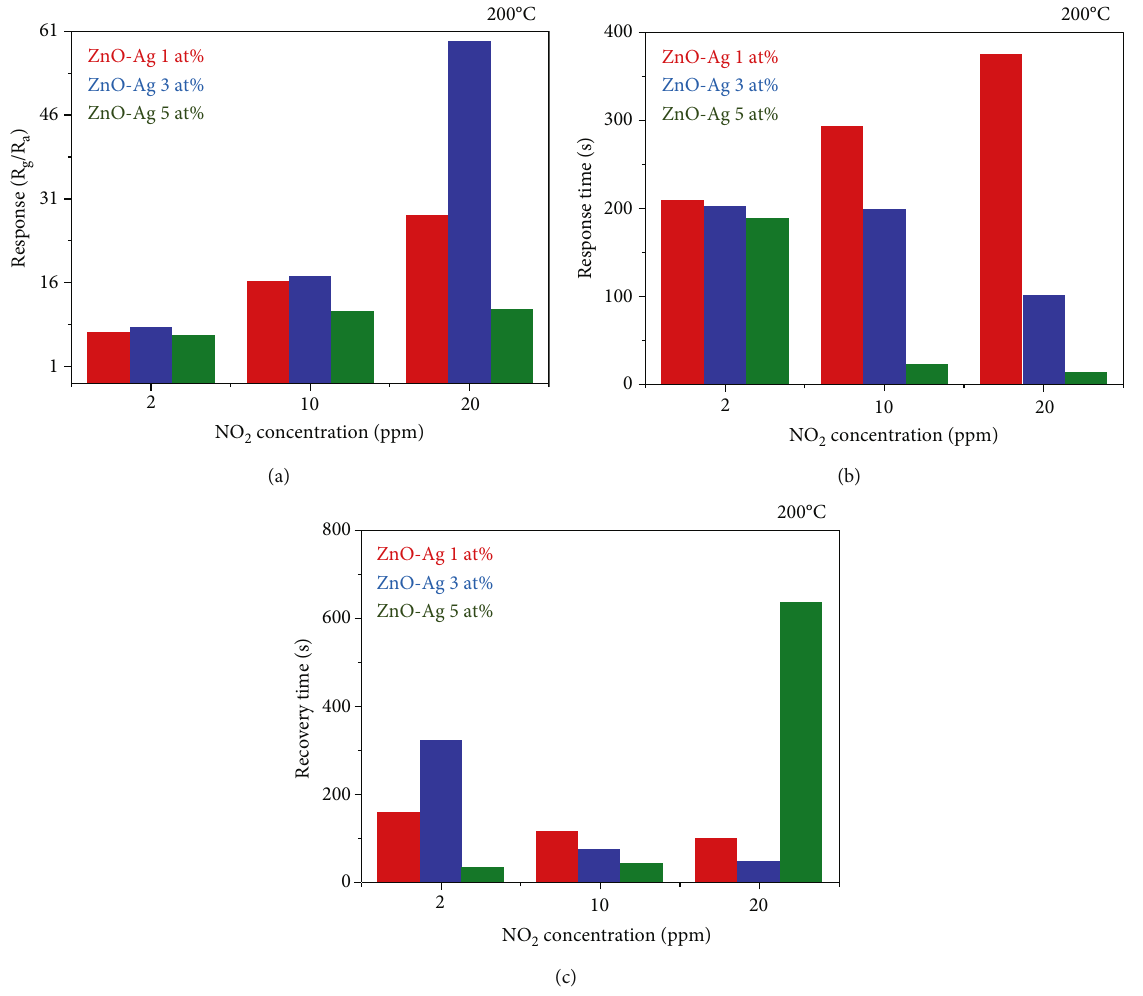
Figure 7: (a) Response, (b) response time, and (c) recovery time of the 1, 3, and 5 at% Ag-functionalized porous ZnO sheet gas sensors to gas at 200 ° NO 2 Table 1: Response, response time, and recovery time of 1, 3, and 5 at% Ag-functionalized porous ZnO sheets gas sensors to di ff erent gas at 200 ° C. concentrations of NO 2